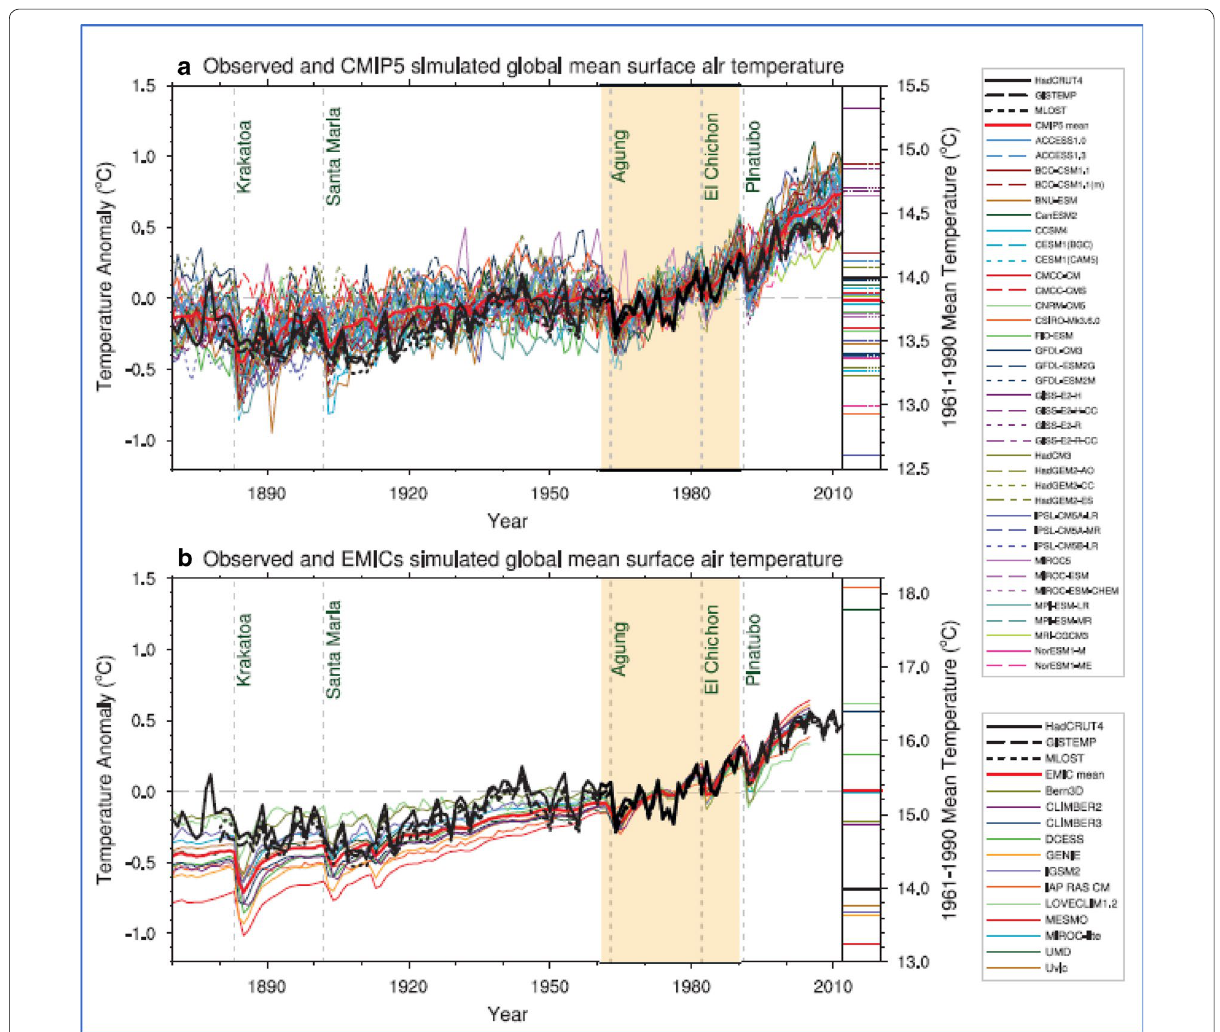
Fig. 1 Observed and simulated time series of the anomalies in annual and global mean surface temperature. All anomalies are differences from the 1961–1990 time-mean of each individual time series. a Single simulations for CMIP5 models (thin lines); b Single simulations from available EMIC simulations (thin lines), from Eby et al. (2013); multi-model mean (thick red line); different observations (thick black lines) (Fig. 9.8 in the original source) (Flato